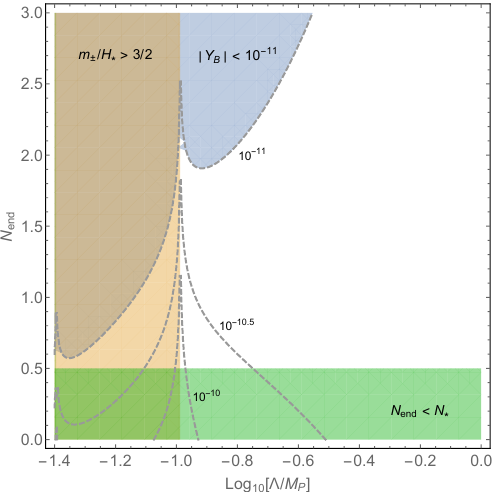
Figure 9 . The parameter scan for the baryon asymmetry | Y B | at the end of inflation from massless AD field ( m = 0 ) in the USR limit δ = − 3 with { c σ 2 H ∗ = 2 . 37 × 10 13 GeV. Dashed lines are contours of | Y B | . Colored regions are excluded by validity of the late-time approximation for m 3 / 2 and the existence of the USR phase ( N 3 ± /H ∗ < where σ = σ ( N ) , A = σ ( ¯ m/H ) e − 3 N ∗ sin[ ¯ m (1 − e − 3 N ∗ ) / (3 H ∗± 2 ± ∗ ± 0 ± ∗ p 3 / (8 π 2 ) H 2 /m 1 ± ∗